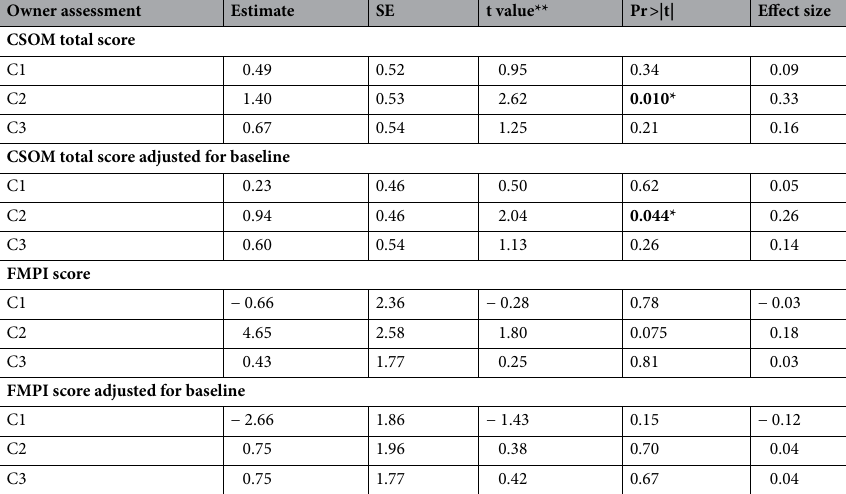
Table 6. Analysis of owner based assessments of client specific outcome measures (CSOM) total score and Feline Musculoskeletal Pain Index (FMPI) score. Estimates show the effect of robenacoxib relative to placebo. SE standard error, C1 contrast 1 = treatment group PP compared against groups RR and RP following 3 weeks of treatment, C2 contrast 2 = treatment group PP compared against group RR following 6 weeks of treatment, C3 contrast 3 = treatment group RP compared against RR for change in activity between weeks 3 and 6 of treatment. P = placebo; R = robenacoxib. *Significance at 0.05 level. **Student’s t statistic for testing whether the contrast equals zero; two-tailed test.